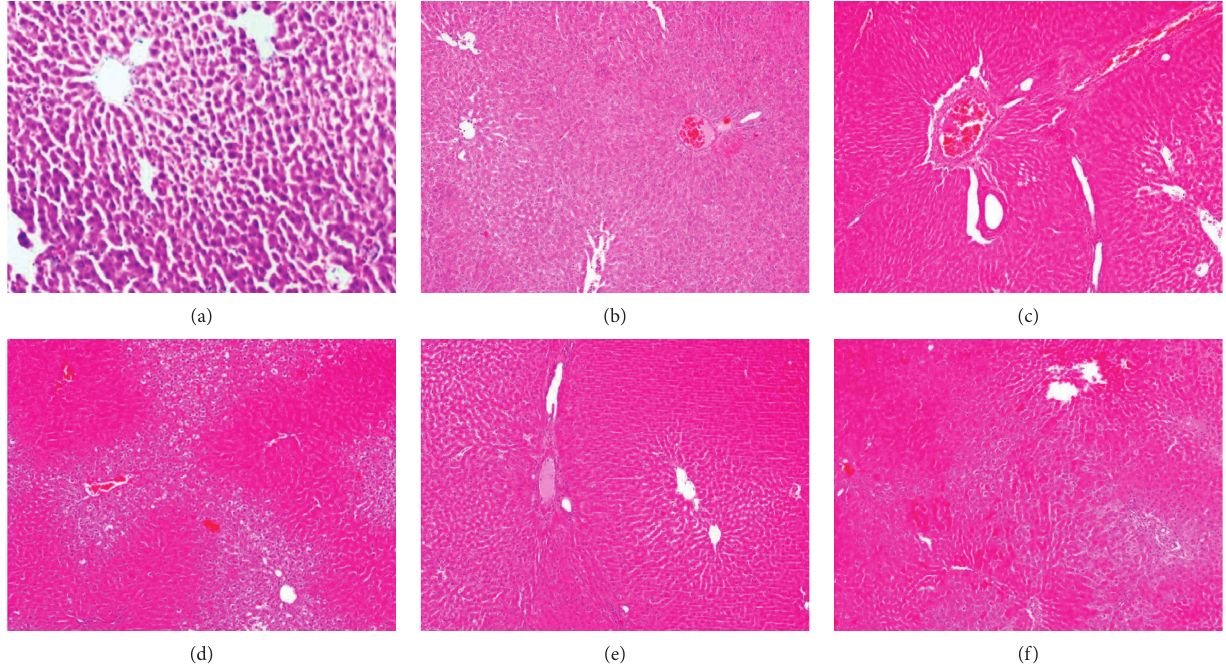
Figure 5: Effect of D. salina on hepatic histopathological changes in albino rats with age-related hepatic steatosis. Age-related hepatic steatosis was induced in rats by injections of D-galactose (200 mg/kg I.P) for eight weeks. Rats injected with oral D-galactose for two weeks were treated with BDS (450 mg/kg), PDS (30 mg/kg), CDS (30mg/kg), or ZH (250 μ g/kg). Twenty-four hours later, the last dose of the treatment, rats were sacrificed, and the liver tissue was isolated and fixed with 10% formalin for histopathological examination (40x magnification, H&E). Figure 7. Oral treatment of D-galactose-treated rats with D.